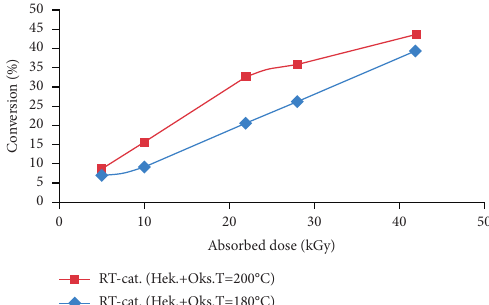
Figure 4: Dependence of the conversion rate of hexane on the surface of the nano-Al